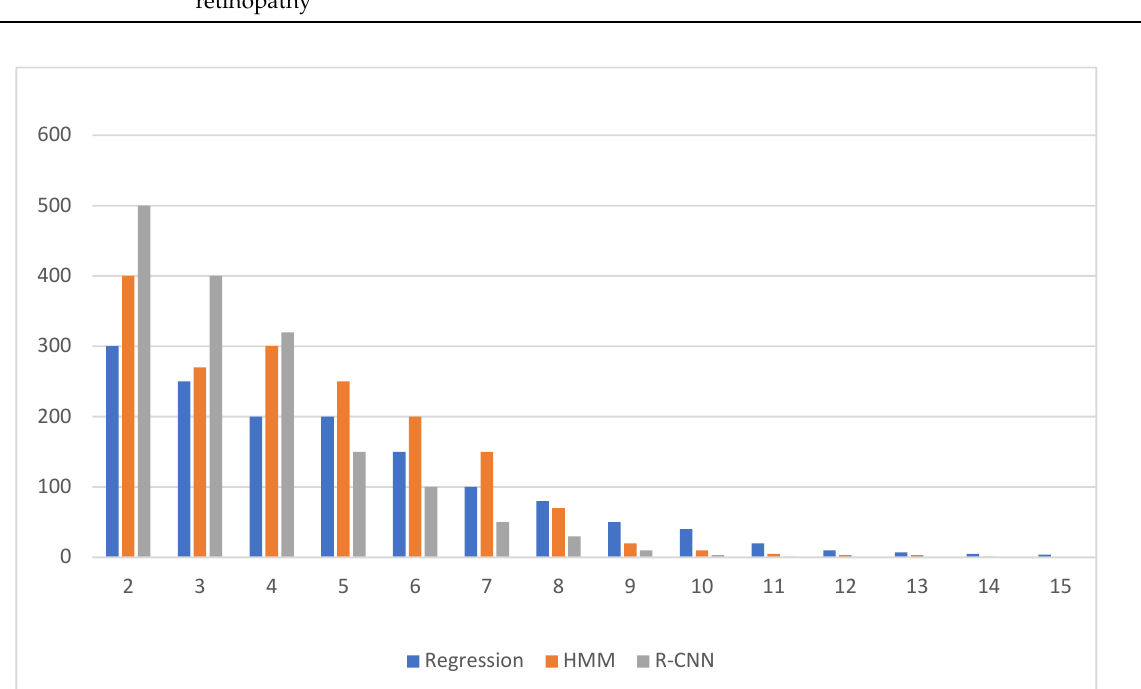
Figure 5. The number of cases according to the mean prediction error (DB). The visual field mean absolute error is depicted in Figure 6. Of the 62 DV points, R-CNN displayed the least classification error in the different methods. R-CNN displayed considerably higher precision at point 30 (red circles) and point 50 (blue circles) as opposed to the regression and HMM, respectively.